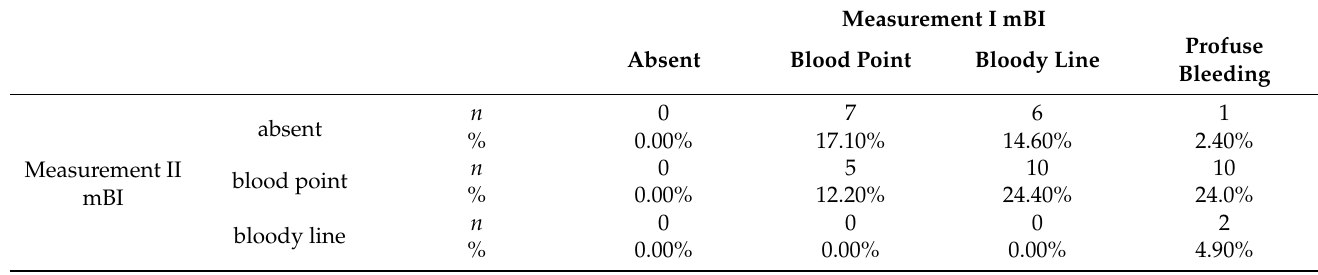
Table 1. The incidence of bleeding gums before (measurement I) and after treatment (measurement II) with a bioactive healing abutment containing clindamycin.